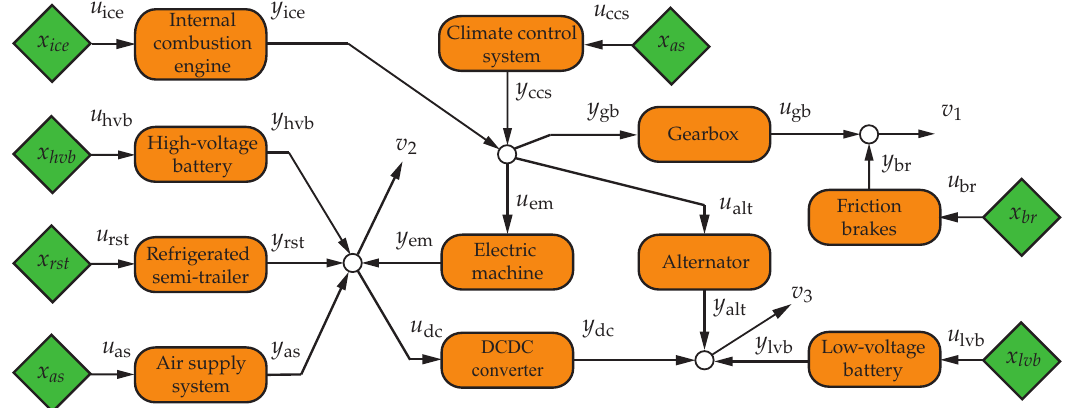
Figure 1. Topology of a hybrid truck with high-voltage and low-voltage auxiliaries and where the arrows indicate the direction of a positive power